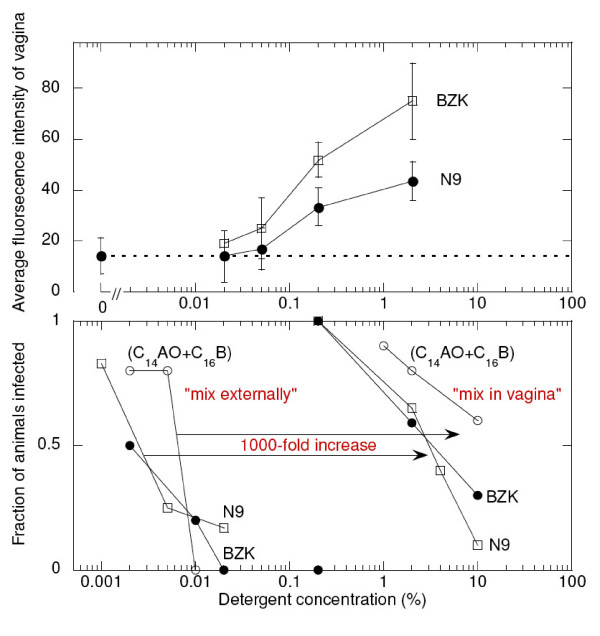
Acute toxicity, and fraction of mice infected, vs detergent concentration. The upper panel shows the average fluorescent intensity of the YOYO-1 stained vagina as a function of the concentration of detergent to which each vagina was exposed for 10 minutes. The lower panel shows the fraction of mice infected using two different test methods: 'mix externally' fully exposes HSV in a high-dose inoculum (10 ID50) to the microbicide prior to inoculation, and 'mix in vagina' mimics human use of a microbicide, the microbicide is delivered to the vagina before delivering the high-dose (10 ID50) inoculum. The two detergents in C31G, (C14AO+C16B), were combined at equal w/v concentrations and plotted at the total detergent concentrations shown.